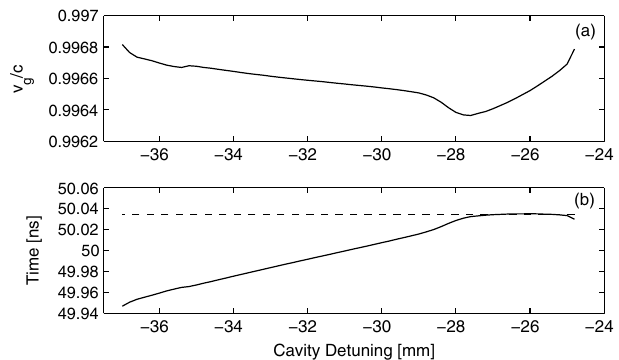
FIG. 4. The resonant wavelength is 1592 (cid:1) m . The group ve- locities and the corresponding round-trip times of the optical pulses calculated at the saturation are presented in (a) and (b), respectively. The dashed line in (b) is the period between successive electron bunches multiplied by